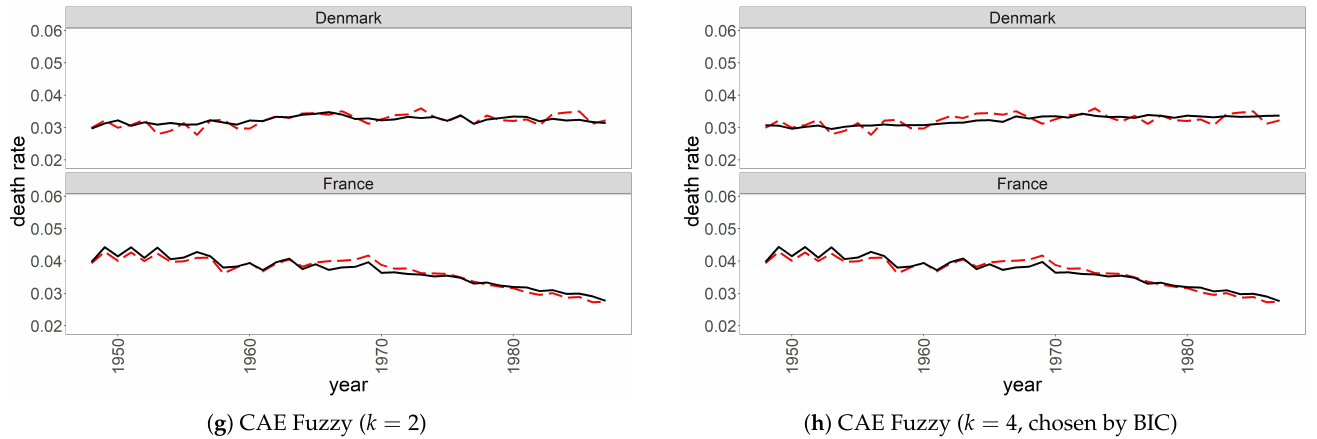
Figure 5. Actual (red, dashed) and fitted (black, solid) central death rates for males aged 67 in Denmark and France (models calibrated on 10 countries) between 1948 and 1987.